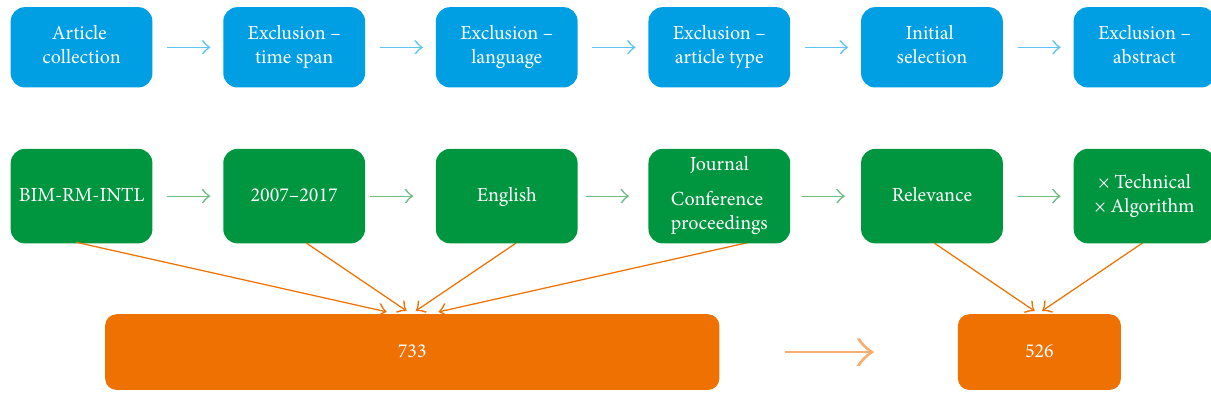
Figure 1: Paper retrieval